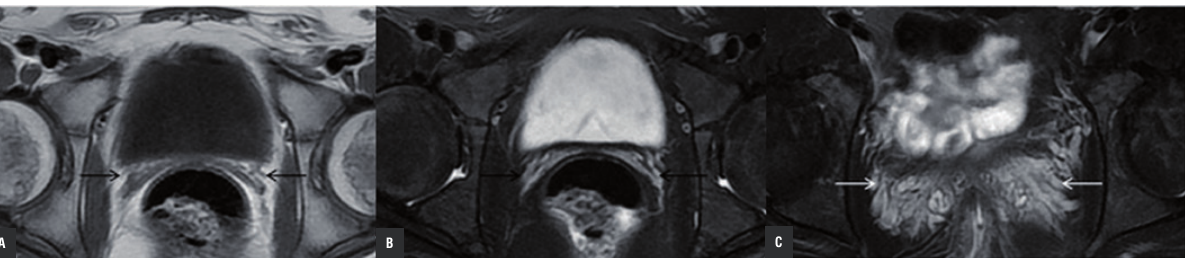
Figure 2 - Bilateral sv hypoplasia in an 18 year old male patient with complaints of pelvic pain. Axial (a) T1 weighted MR image and axial (b, c) fat-saturated T2 weighted MR images show both sv were significantly small (black arrow). Congestion were visualized in pelvic vascular structures at the sv location (white arrow).